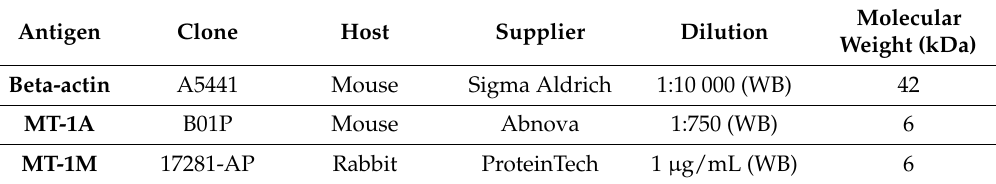
Table 2. Details of primary antibodies used for experiments.